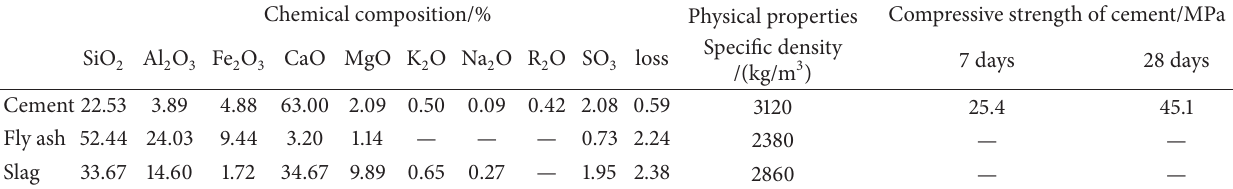
Table 1: Chemical and physical properties of cement, fly ash, and slag.